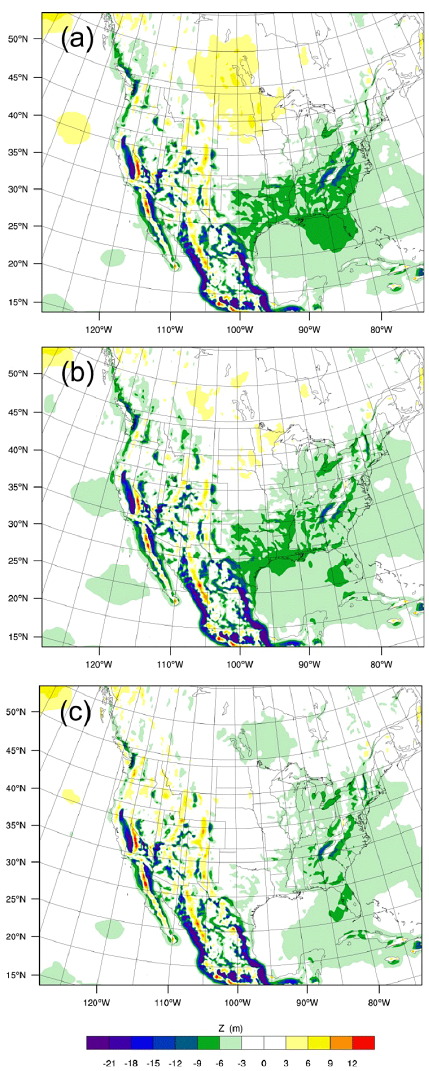
Figure 3. Averaged geopotential height differences at 500hPa between (a) WRF 6h forecast and ECMWF reanalysis, (b) BLD_DA_1200 6h forecast and ECMWF reanalysis, (c) BLD_ANA_1200 6h forecast and ECMWF